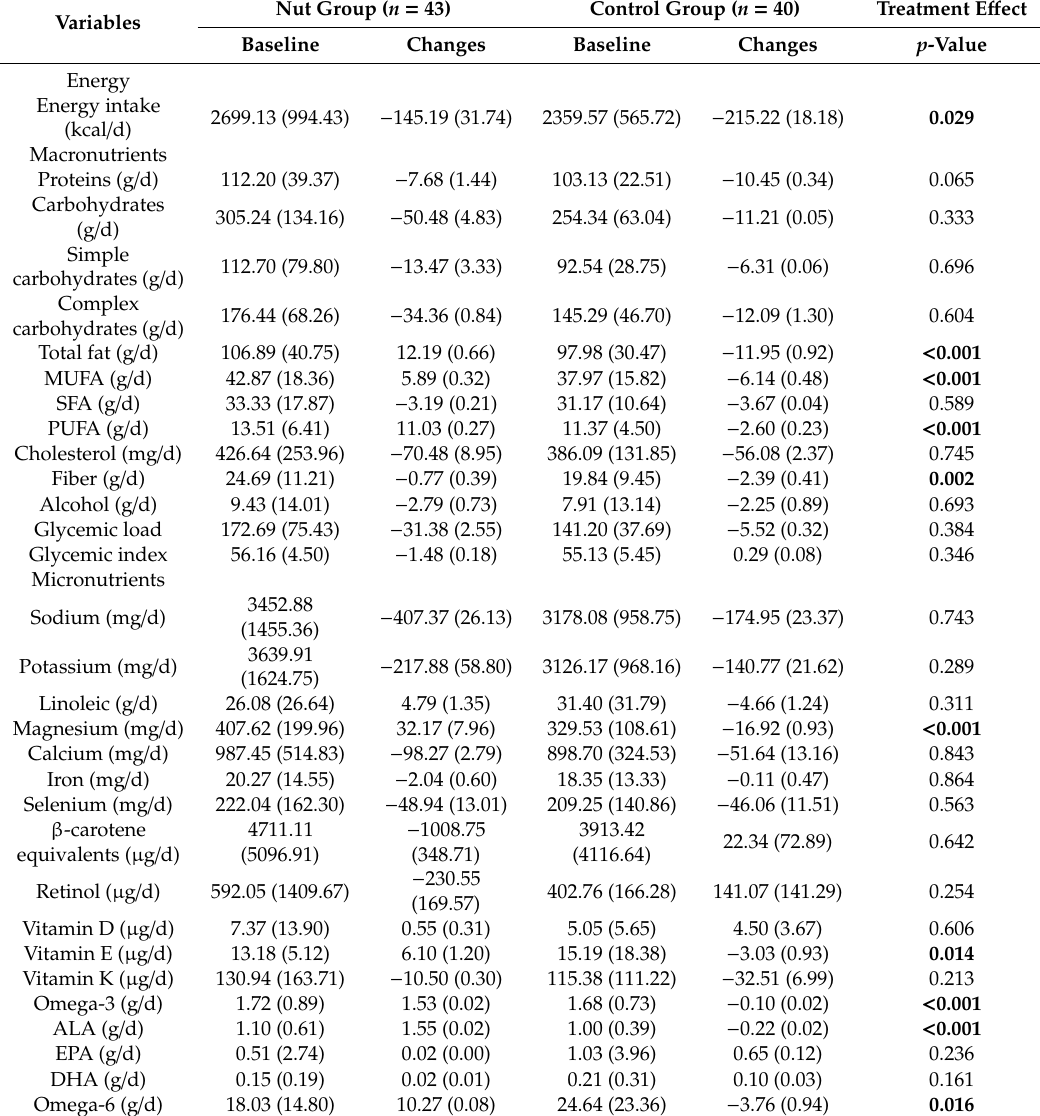
Table 2. Nutrient intake at baseline and changes by intervention group.